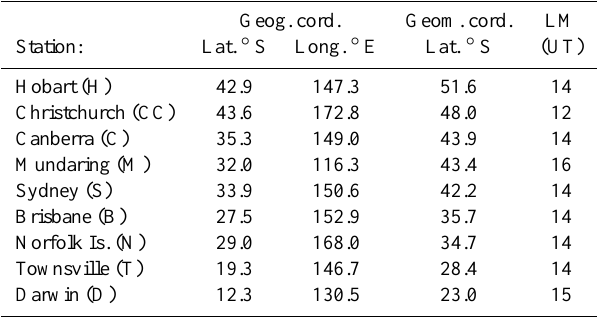
Fig. 1. Geographical positions of ionosonde stations used in this study. The solid and broken lines refer to the latitudinal maxima in Sr (MAX.1 and MAX.2) and the dotted line refers to the latitudinal minimum (MIN.). Table 1. Ionosonde stations used in this report in the Australian- New Zealand sector. Local midnight (LM) is shown in UT. Geog. cord. Geom. cord.